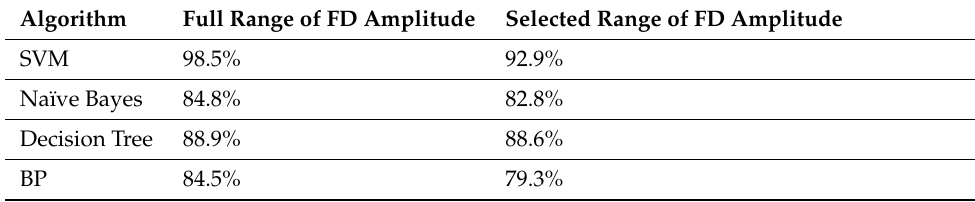
Table 4. Performance of different ML models with FD